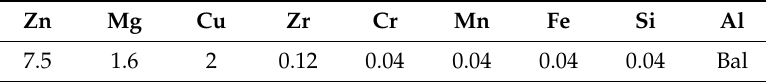
Table 1. Chemical composition of 7085 alloy (wt%).